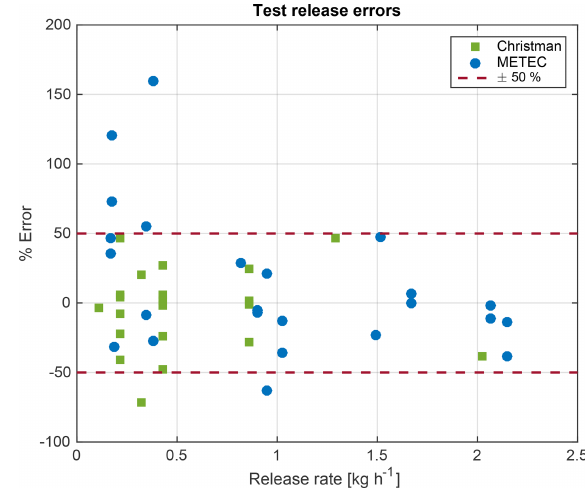
Figure 4. Scatterplot of test release error and release rate. Positive percent error corresponds to OTM 33A overestimating the known release rate.